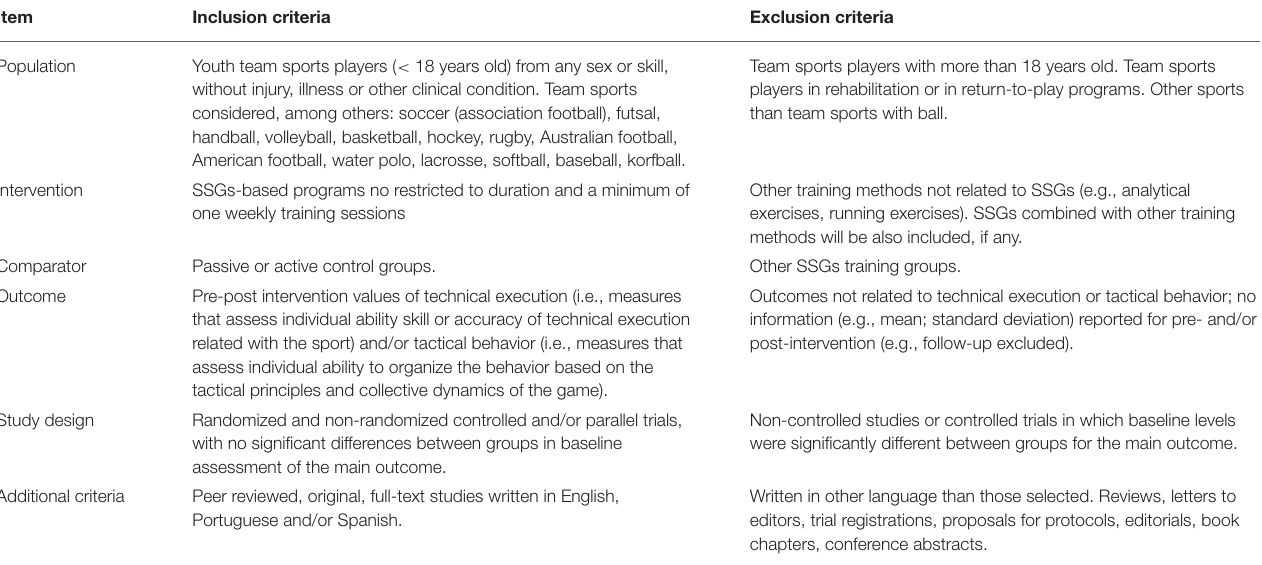
TABLE 1 | Inclusion and exclusion criteria.